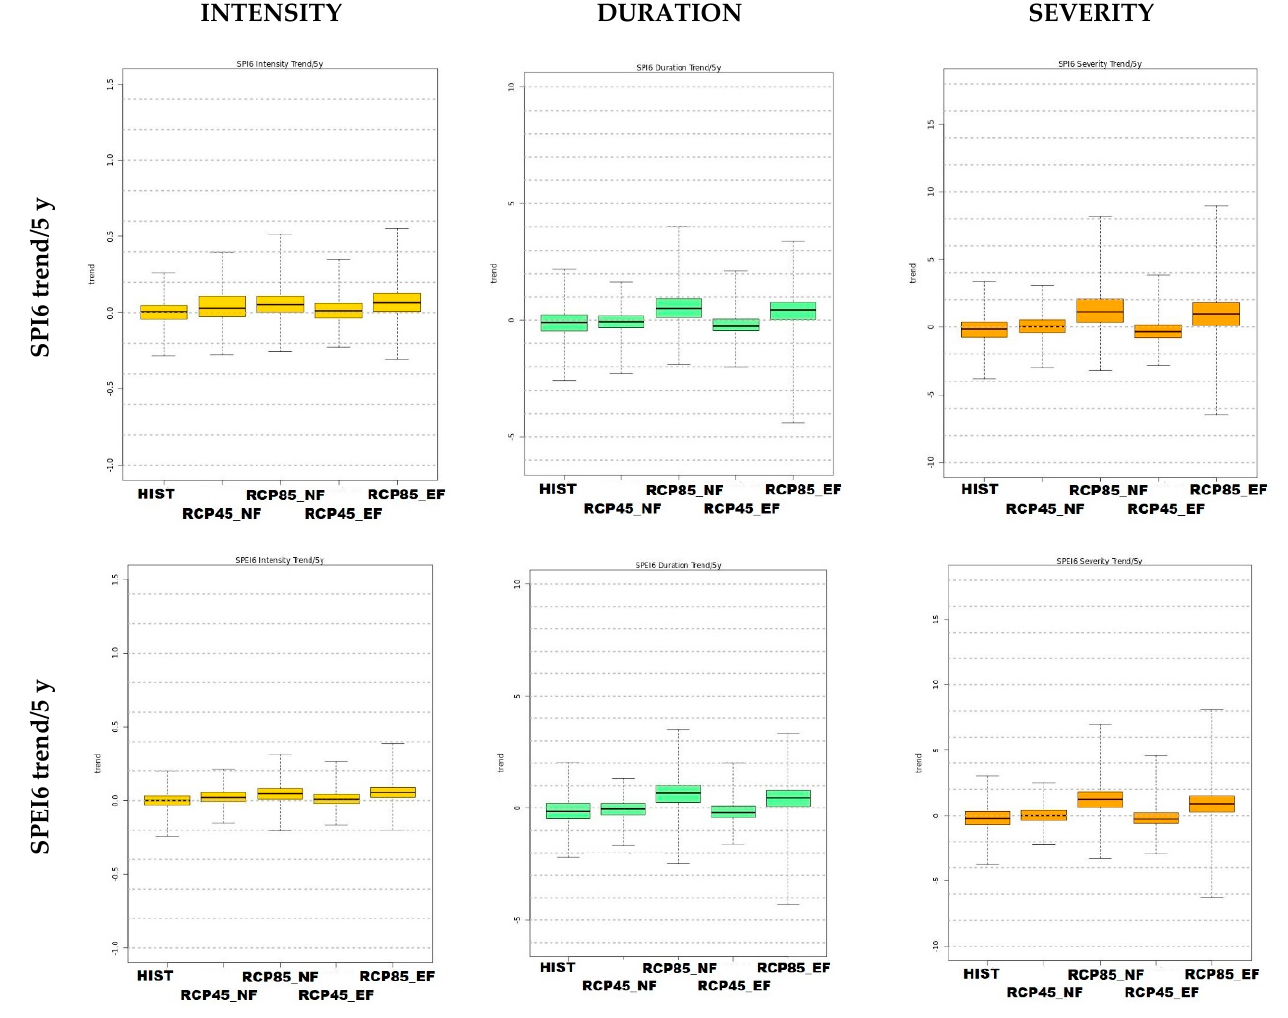
Figure 9. Five-year mean trends of drought severity, intensity and duration averaged over land area, for the 6-month SPI/SPEI under RCP4.5 and RCP8.5 for the near period 2025–2049, as RCP45_NF and RCP85_NF, the far future period 2075–2099 as RCP45_EF and RCP85_EF and the reference pe- riod (1980–2004) as HIST.